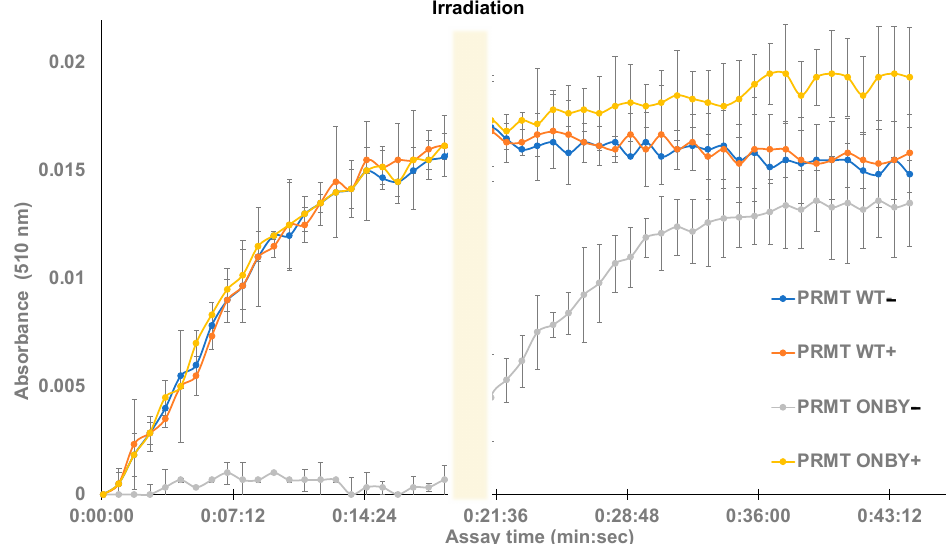
Figure 3. Temporal control of caged-PRMT1. Protein samples were briefly irradiated (+) prior to assay initiation or left initially non-irradiated ( − ). Methyltransferase assays were conducted in triplicate in a 96-well plate and monitored at 510 nm for the downstream product of enzyme activity. The wild-type (both irradiated and non-irradiated) and the irradiated ONBY-PRMT1 samples exhibited similar kinetic profiles within deviation, while the non-irradiated ONBY-PRMT1 did not harbor enzymatic activity. However, after 20 min, the assay was briefly irradiated, resulting in a gain in function of the previously photocaged protein.